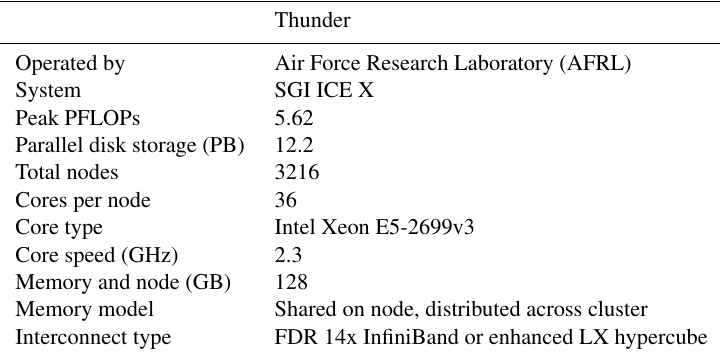
Table 3. Hardware used in VIC image driver parallel scaling performance